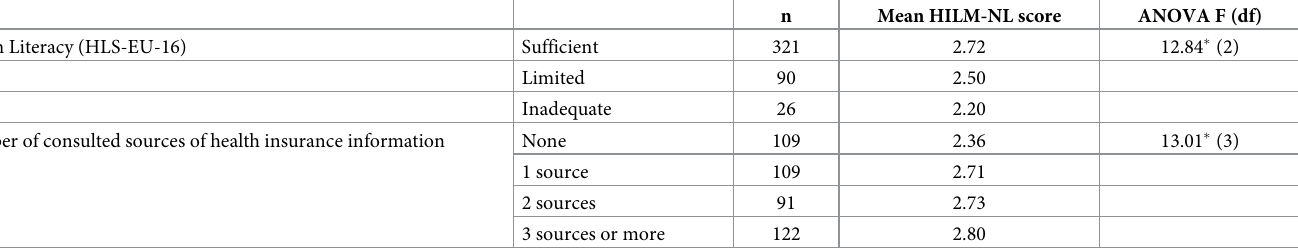
Table 5. The association between the mean HILM-NL scores and HLS-EU-16 levels, and the number of self-reported sources of health insurance information